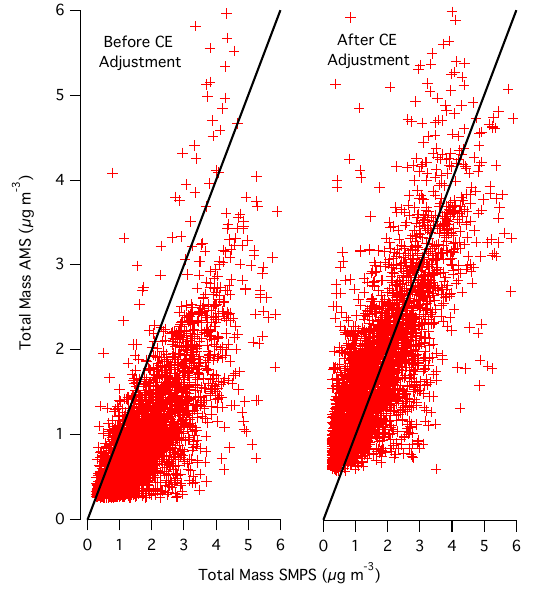
Fig. A4. Comparison of collection efficiency (CE) corrected AMS mass measurements to calculated total mass measured by SMPS. The plot on the left is the trend before CE correction (slope = 0.45), the plot on the right is the trend after CE correction (slope = 0.85). concentration assuming a density of 1.6gcm − 3 , which is repre- sentative of a mixture of 60% sulfuric acid ( ρ = 1 . 84gcm − 3 ) and 40% organics ( ρ = 1 . 2gcm − 3 ) (Phinney et al.,